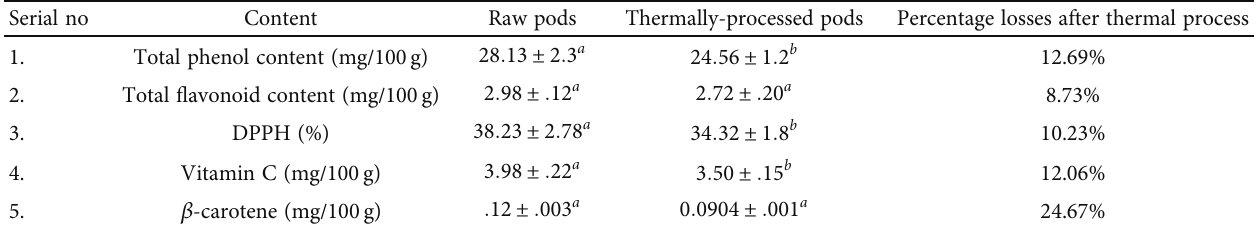
Table 2: E ff ect of thermal processing on the antioxidant properties of Moringa oleifera pods. Serial no Content Raw pods Thermally-processed pods Percentage losses after thermal